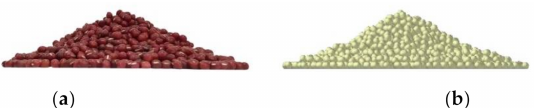
Figure 9. Comparative test of AOR of ABS. ( a ) physical test; ( b ) simulation